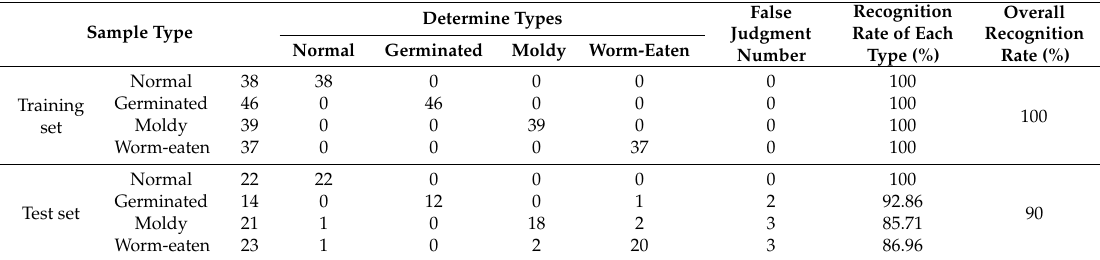
Table 4. Modeling results of Poly SVM wheat classification fusion